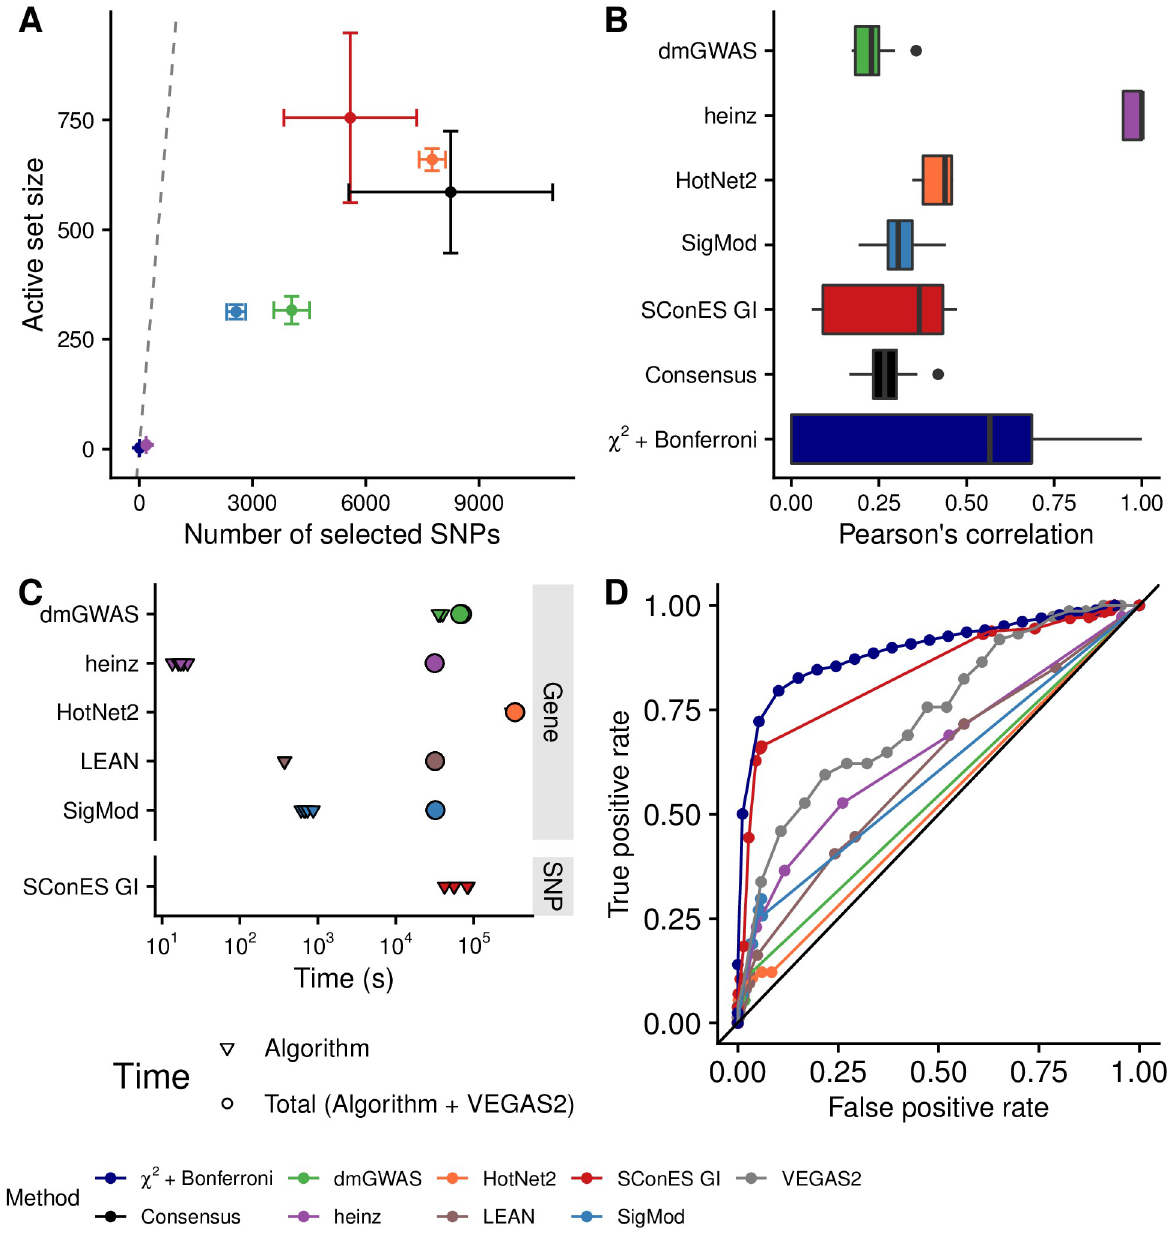
Fig 3. Comparison of network methods on GENESIS. Each method was run 5 times on a random subset containing 80% of the samples and tested on the remaining samples (Section 2.5). As LEAN did not select any gene, we excluded it from panels A and B. (A) Number of SNPs selected by each method and number of SNPs in the active set (i.e., the number of SNPs selected by the classifier, Section 2.5.2). Points are the average over the 5 runs; the error bars represent the standard error of the mean. A grey diagonal line with slope 1 is added for comparison, indicating the upper bound of the active set. For reference, the active set of the classifier using all the SNPs as input included, on average, 154 117.4 SNPs. (B) Pairwise Pearson correlations of the solutions produced by different methods. A Pearson correlation of 1 means the two solutions are the same. (C) Runtime of the evaluated methods, by type of network used (PPIN or SNP). For gene-based methods, inverted triangles represent the runtime of the algorithm alone, and circles the total time, which includes the algorithm themselves and the additional 119 980 seconds (1 day and 9.33 hours) that VEGAS2 took on average to compute the gene scores from SNP summary statistics. (D) True positive rate and false positive rate of the methods, obtained using different parameter combinations (Section 3.7). We used as true positives BCAC-significant SNPs (for SConES and χ 2 + Bonferroni) and genes (for the remaining methods, Section 2.6). We used the whole dataset in this panel.